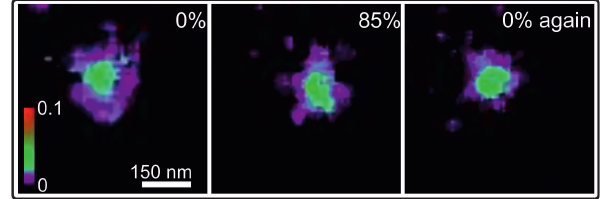
Fig. 12. Absorption maps of a fresh EURO 3 passenger car soot particle measured before the carbon absorption edge at 280eV at different